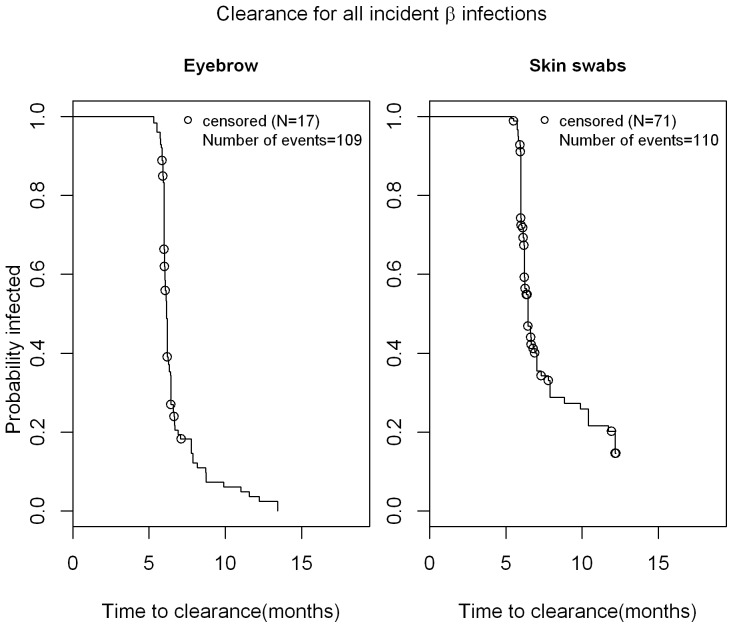
Time to clearance of β-HPV infection in normal skin swabs and eyebrow hairs of men.Kaplan Meier estimate for time to clearance for all type-specific incident infections a study participant (n = 209) had before their last visit with a valid sample. The 'last observation carried forward' approach was taken when counting time to clearance (e.g. for 0 1 NA 0 pattern of HPV positivity, the NA was treated as '1' and the time was counted towards the time to clearance). This only affected skin swab samples since most people were β globin or HPV positive for eyebrows and thus their samples were not removed.